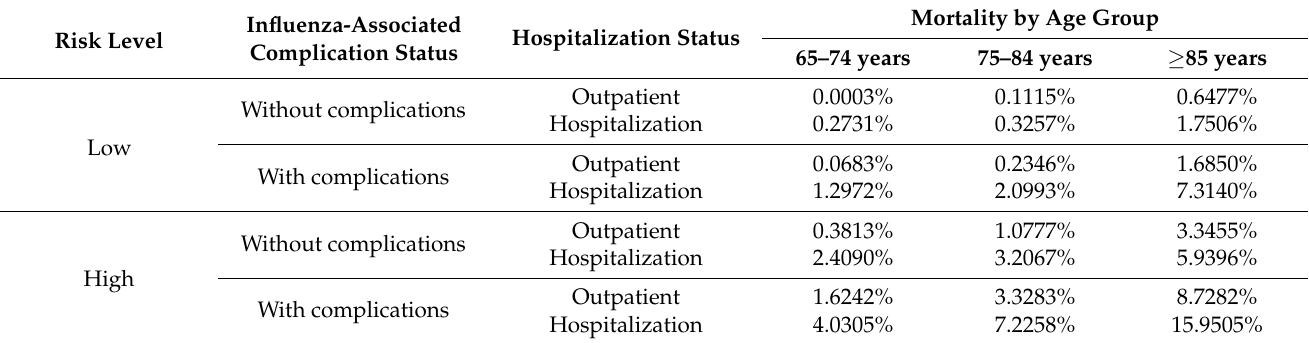
Table 2. Mortality stratified by age group, risk level, influenza-associated complication status, and hospitalization status